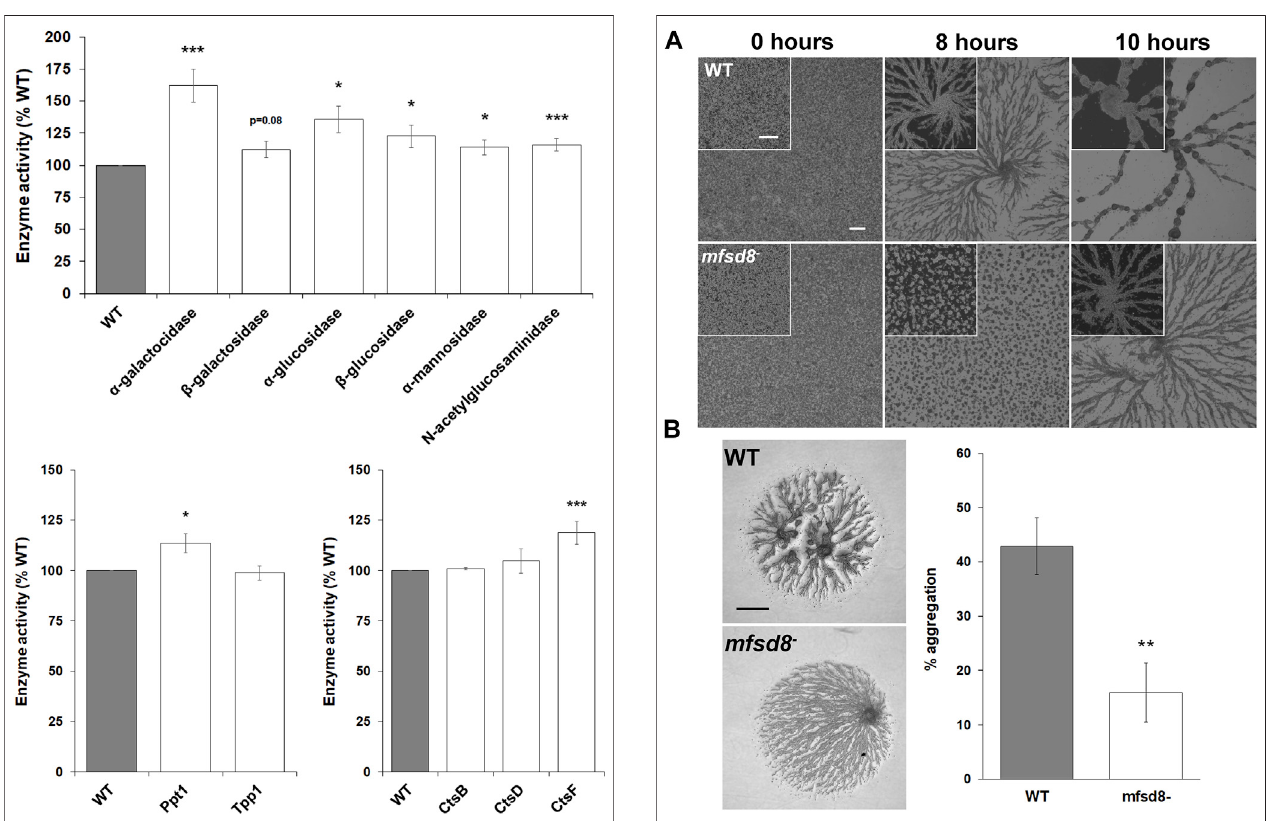
FIGURE4| Effectof mfsd8 -de fi ciencyonenzymeactivityduringgrowth. WT and mfsd8 − cells grown axenically in HL5 were collected and lysed. The activities of α -galactosidase, β -galactosidase, α -glucosidase, β -glucosidase, α -mannosidase, N-acetylglucosaminidase, palmitoyl-protein thioesterase 1 (Ppt1), tripeptidyl peptidase 1 (Tpp1), cathepsin B (CtsB), cathepsin D(CtsD), and cathepsin F (CtsF) wereassessed asdescribedin the Materials and Methods. Data presented as mean enzyme activity (% WT) ± SEM ( n > 4). Statistical signi fi cance was determined using the one-sample t -test (mean, 100; two-tailed) vs. WT. * p < 0.05 and *** p < 0.001 vs. WT.